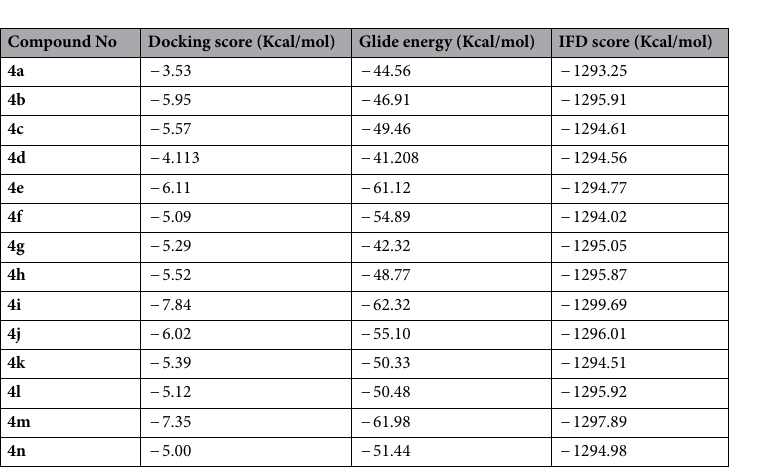
Table 2. Docking score, glide score, and IFD score of compounds ( 4a – 4n ) over α-glycosidase.